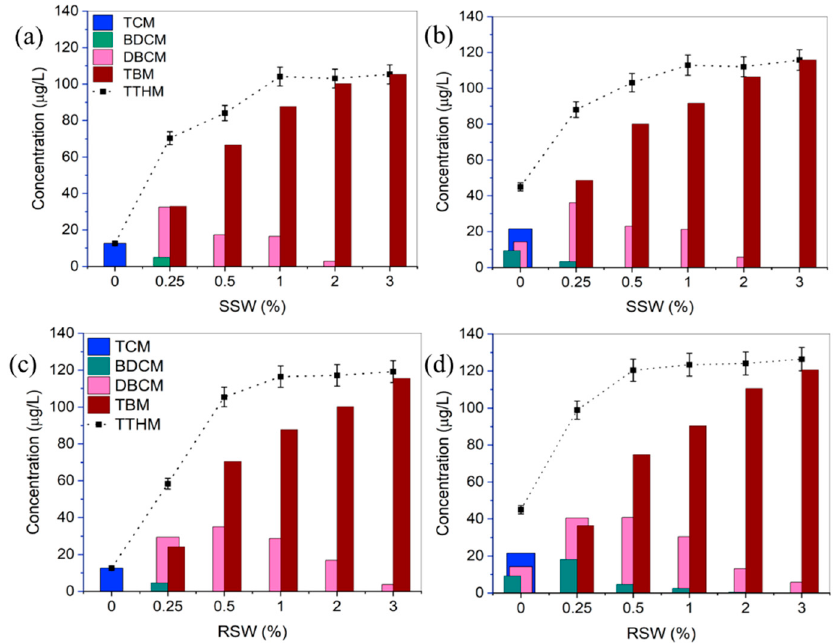
Figure 2. THM formation at varying seawater intrusion levels. SSW: synthetic seawater ( a ) after 24 h and ( b ) after 48 h; RSW: real seawater ( c ) after 24 h and ( d ) after 48 h.